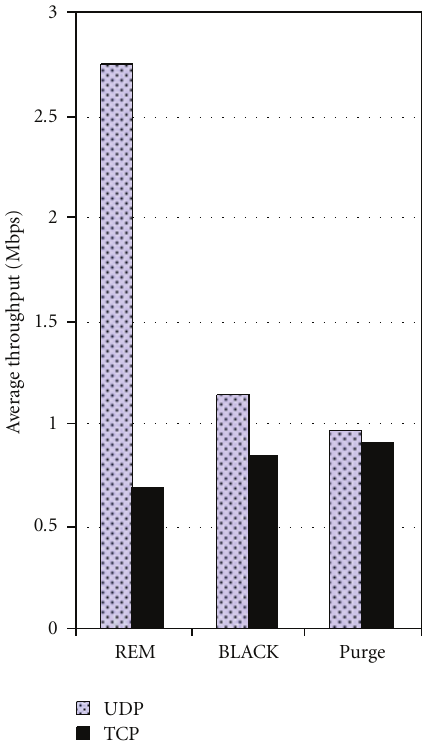
Figure 7: Average throughput in a single unresponsive flow